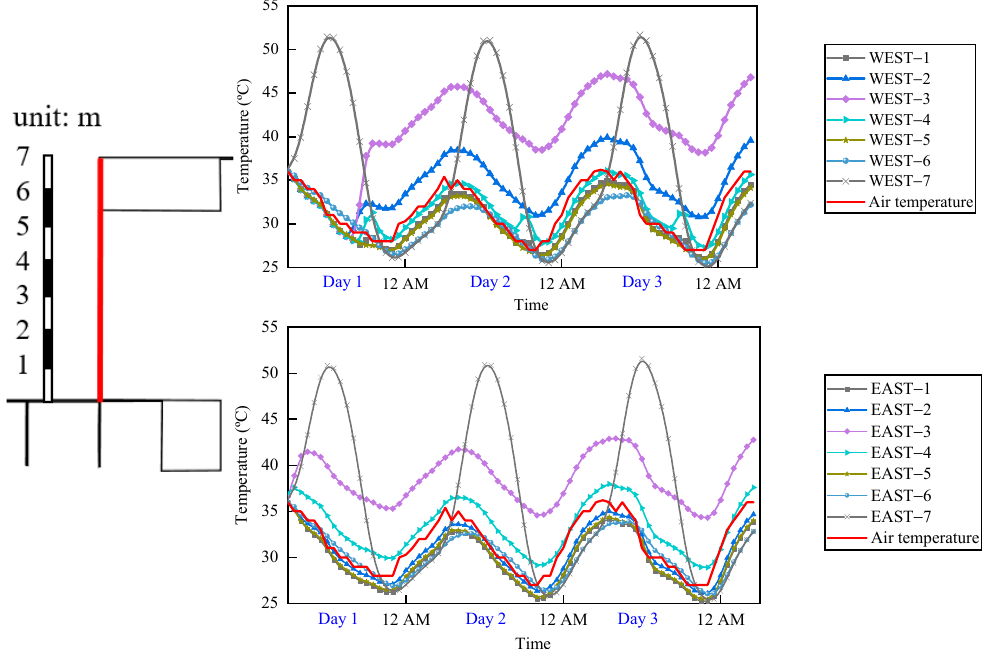
Figure 12. Temperature changes of several points on eastern and western inner surfaces of the empty aqueduct in summer (WEST stands for the western inner surface, and EAST represents the eastern inner surface. The number after the hyphen is its vertical coordinate).